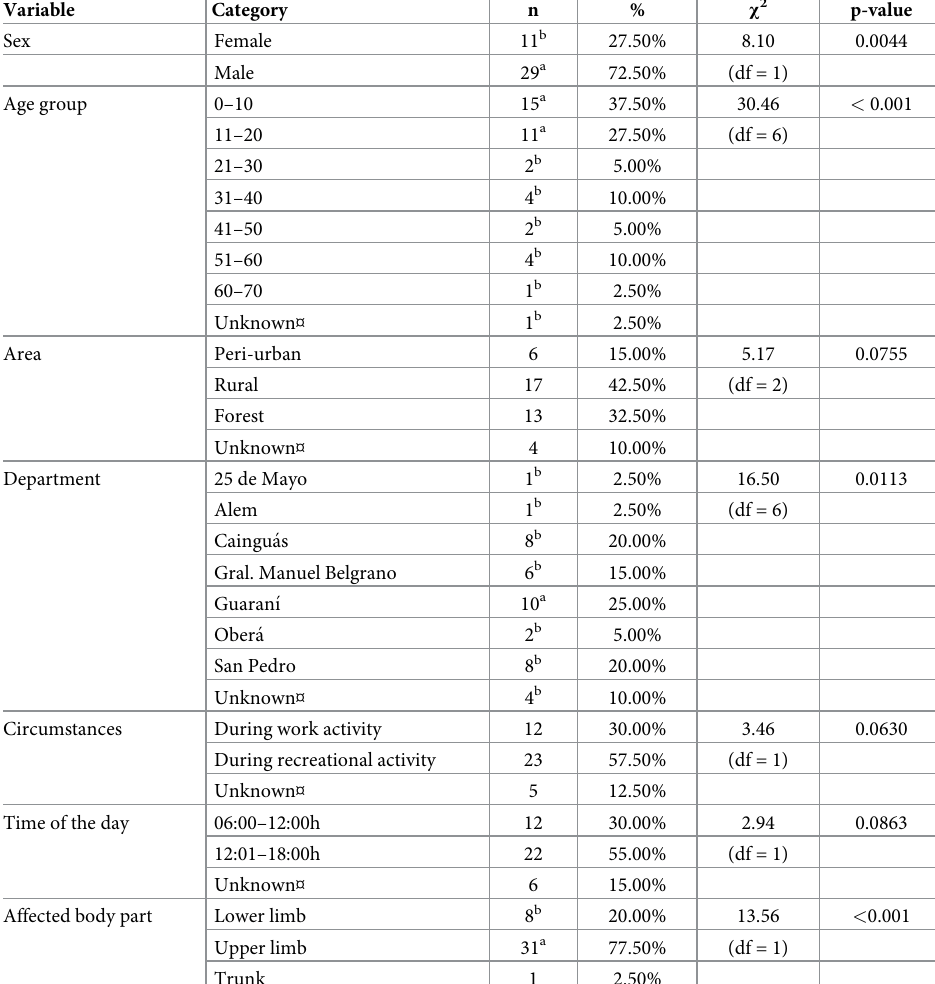
Table 1. Socio-demographic profile of victims of lonomic accidents (n = 40) in Misiones,